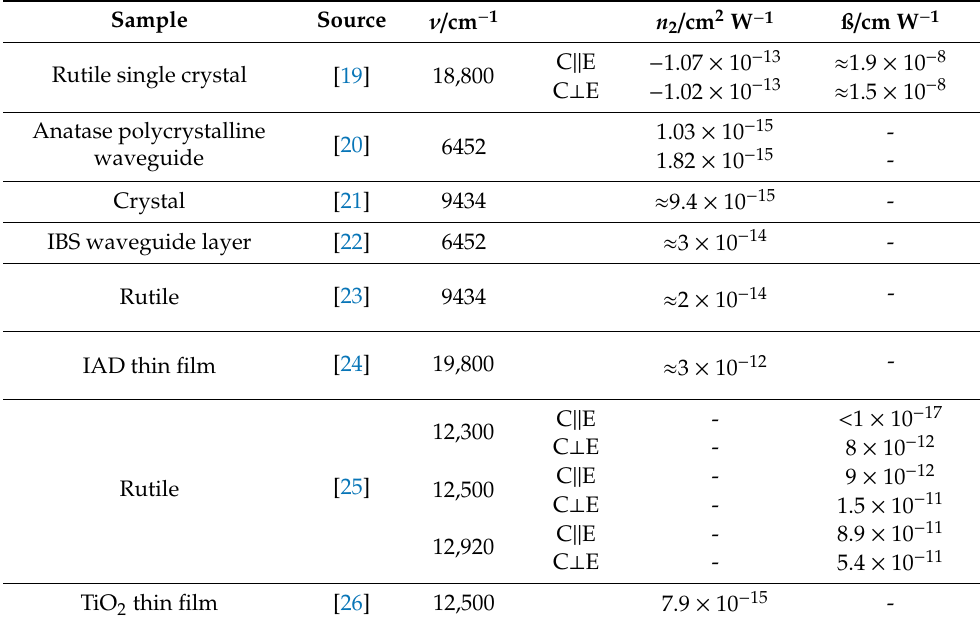
Table 2. Reported values for measured nonlinear TiO 2 optical constants. IAD denotes ion-assisted evaporation. C denotes the direction of the rutile optical axis, while E denotes the direction of the electric field vector in the light wave. IBS: Ion